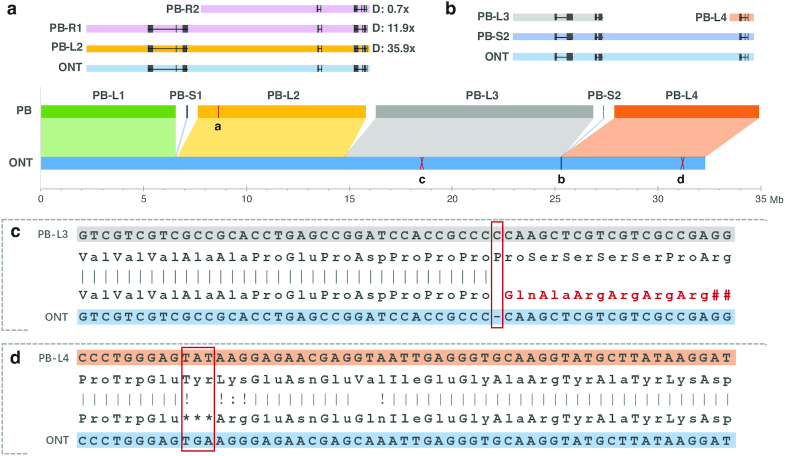
Assembly errors in which genes can be annotated. (a) An example shows gene gains caused by assembly redundancies, of which PB-R1 and PB-R2 had a similarity level of 99.67% and 99.51%, respectively, compared with the corresponding region on PB-L2. D: depth. (b) The gene redundancies caused by gaps that failed to be correctly connected by the PacBio assembly. (c) An example shows how a 1-base deletion led to a frameshift mistake for protein translation. (d) An example shows how a single-base error led to stop codon gain and truncated protein translation.